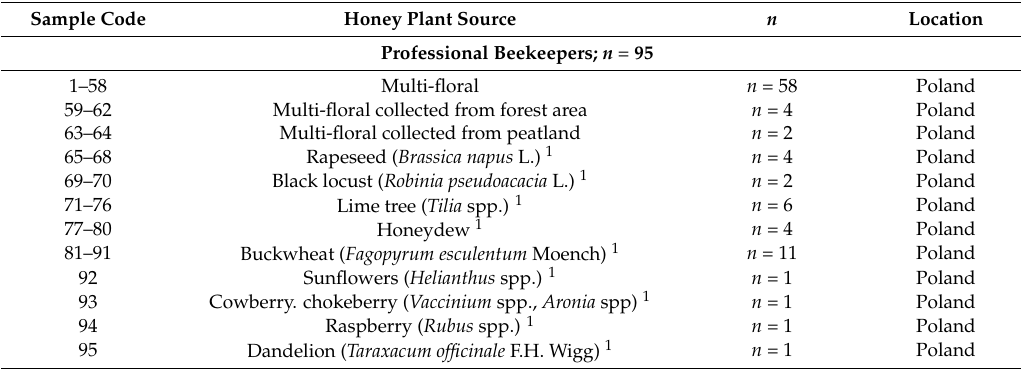
Table 6. Plant origins of honeys tested in the